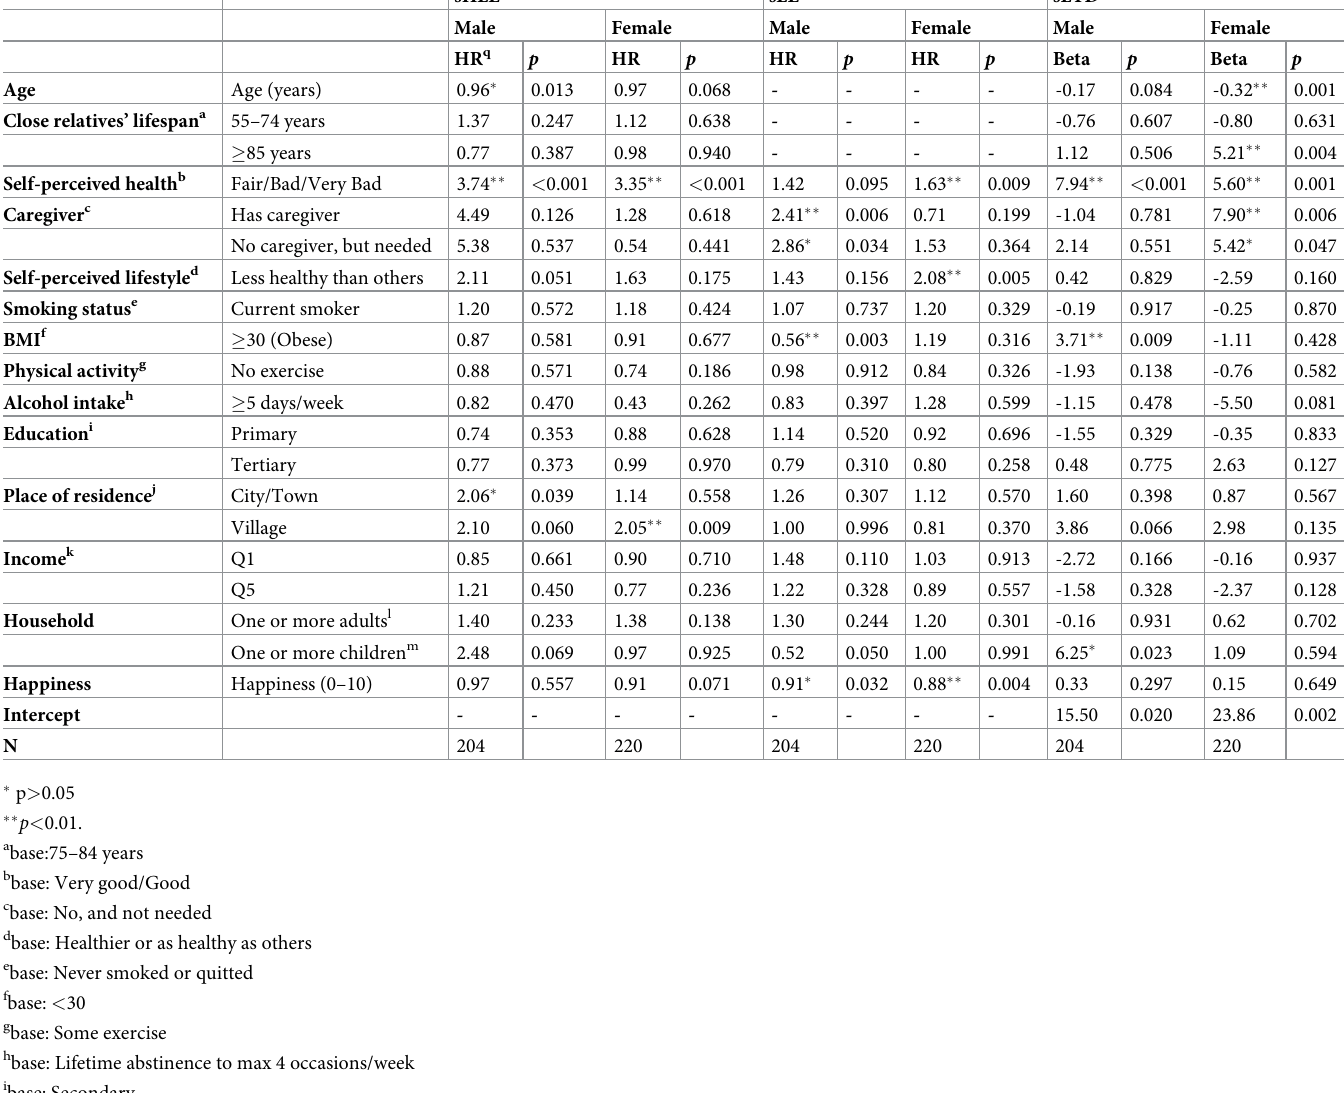
Table 3. Regression analysis of subjective healthy life expectancy, subjective life expectancy and subjective life years with disability by